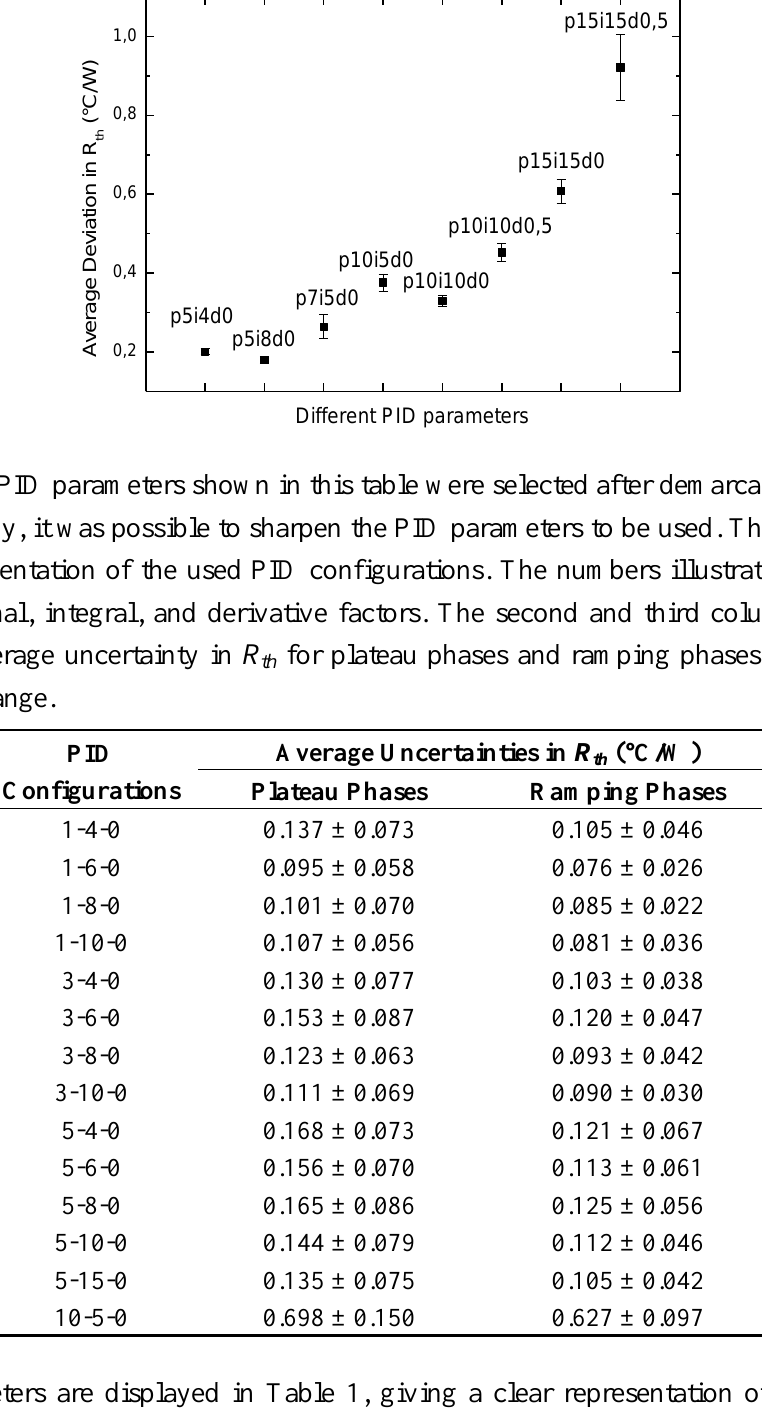
(heat-transfer th